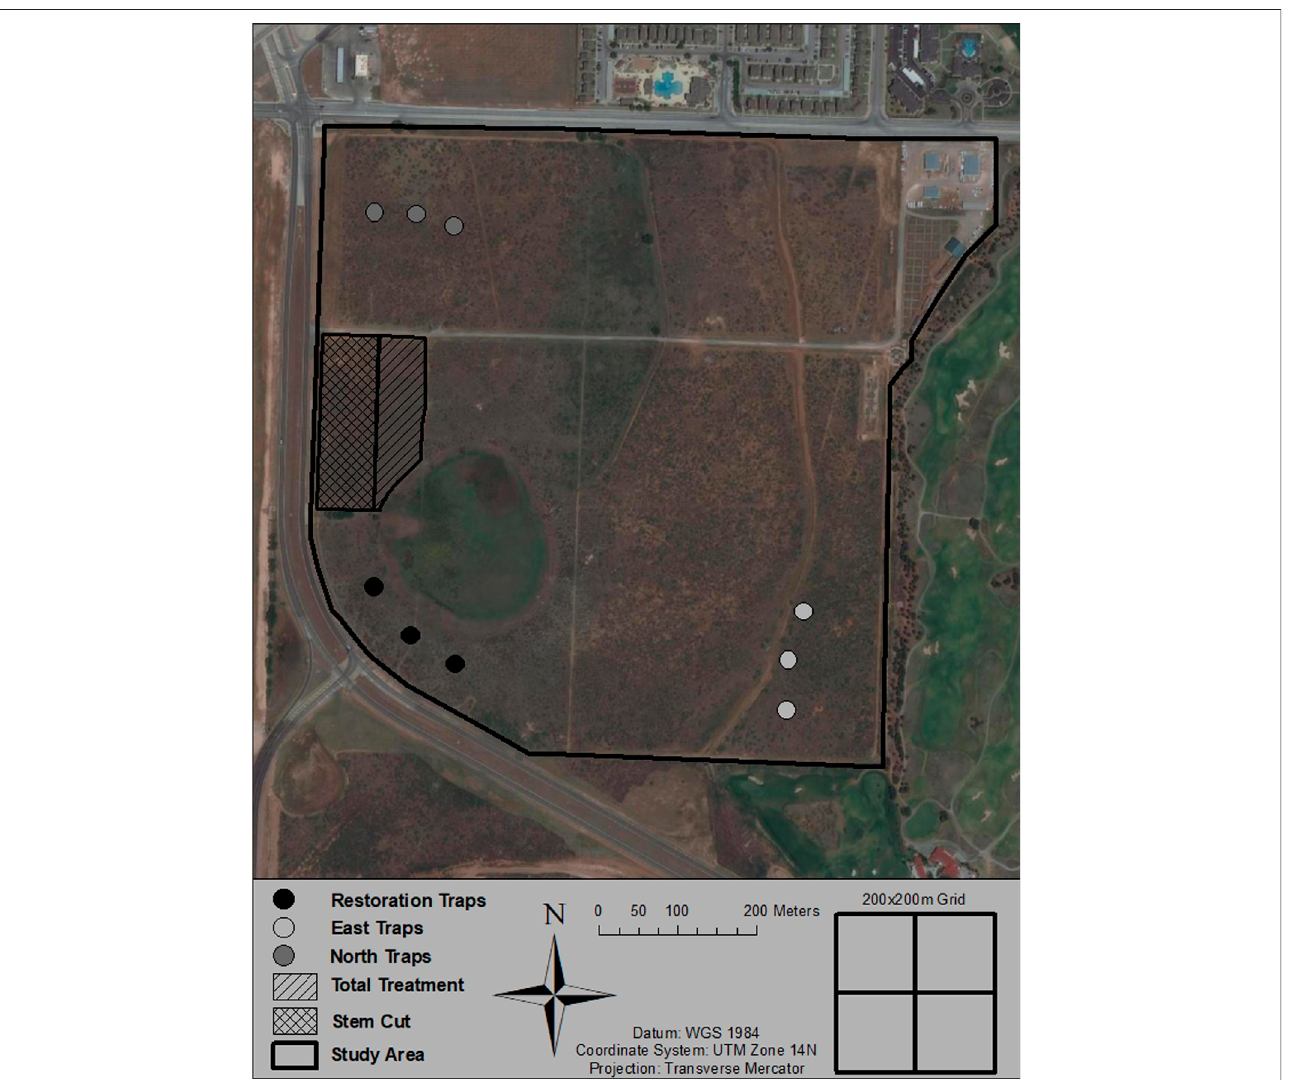
FIGURE1| TheTexasTechUniversityNativeRangeland(LubbockCounty,TX,UnitedStates)studysitewheretherestorationandairborneeDNAsamplingtookplace. Thehatchedlines showthetwodifferentrestorationmethods used andtheclustersofpointsrepresentthethreegroupings ofairborneeDNABigSpringNumberEightDust